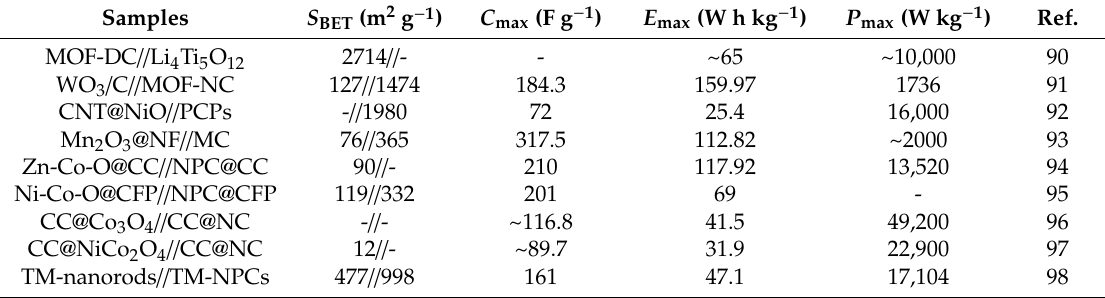
Table 5. Electrochemical performances of the ASCs based on pure and heteroatom-doped